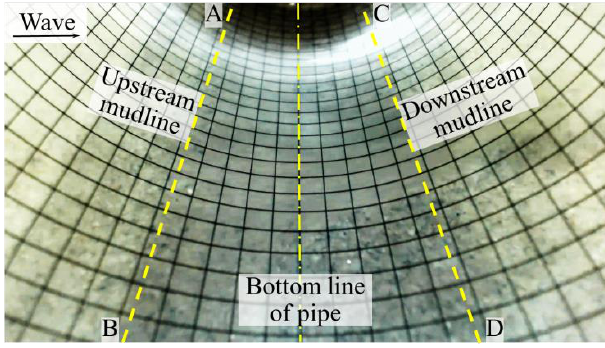
Figure 4. Typical view of the camera.